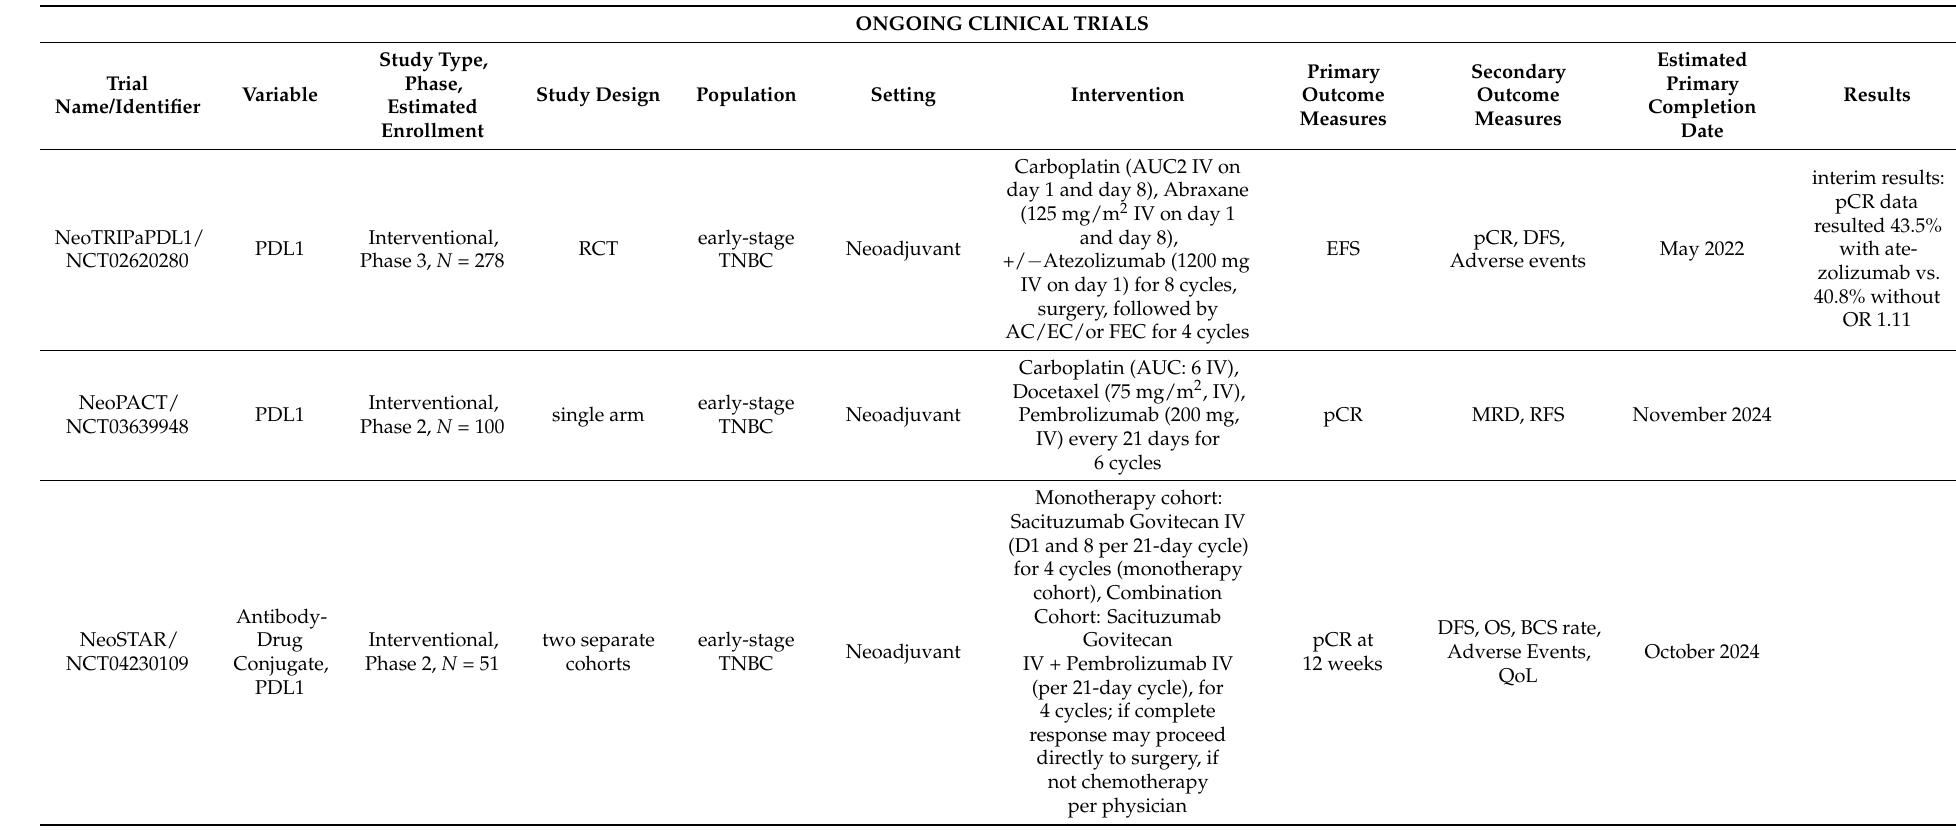
Table 2. Summary of the ongoing and completed clinical trials that provide an opportunity to de-escalate the current standard neoadjuvant regimen for early TNBC